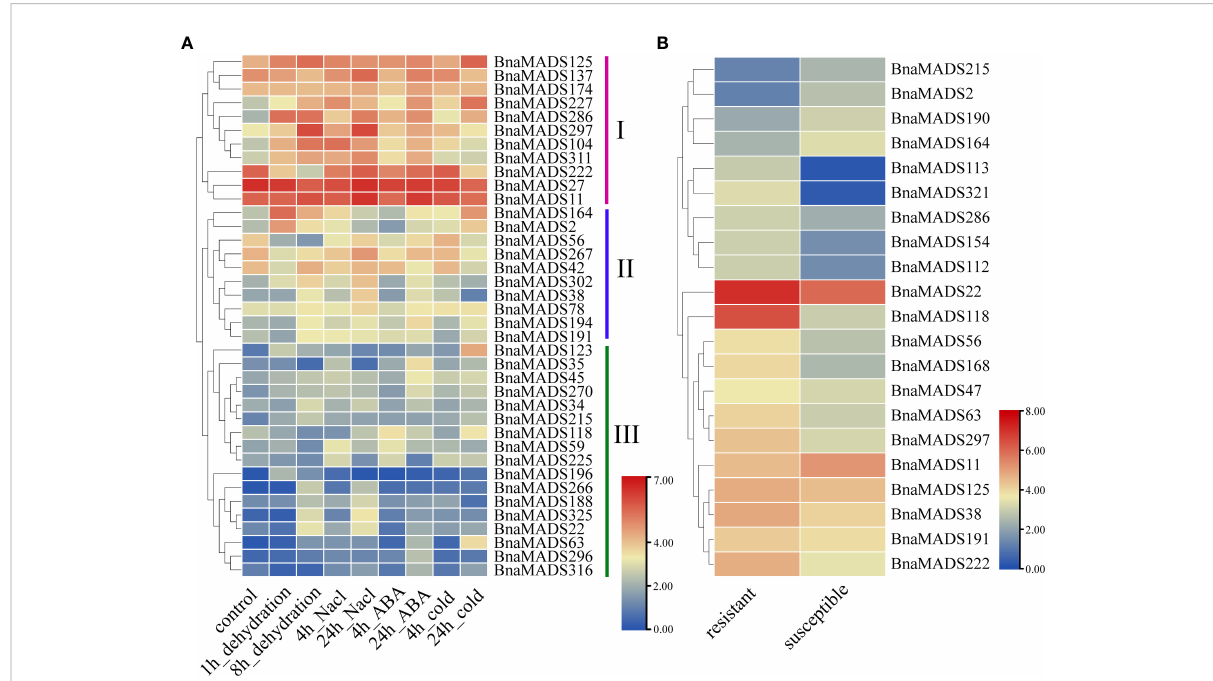
FIGURE 6 Expression of MIKC-type MADS-box genes in response to biotic and abiotic stresses. (A) Expression pro fi les of genes in rapeseed leaves under four different abiotic stressors (dehydration, salt, ABA, and cold). (B) The leaves expression patterns of two different white powder-resistant rapeseed lines after inoculation with powdery